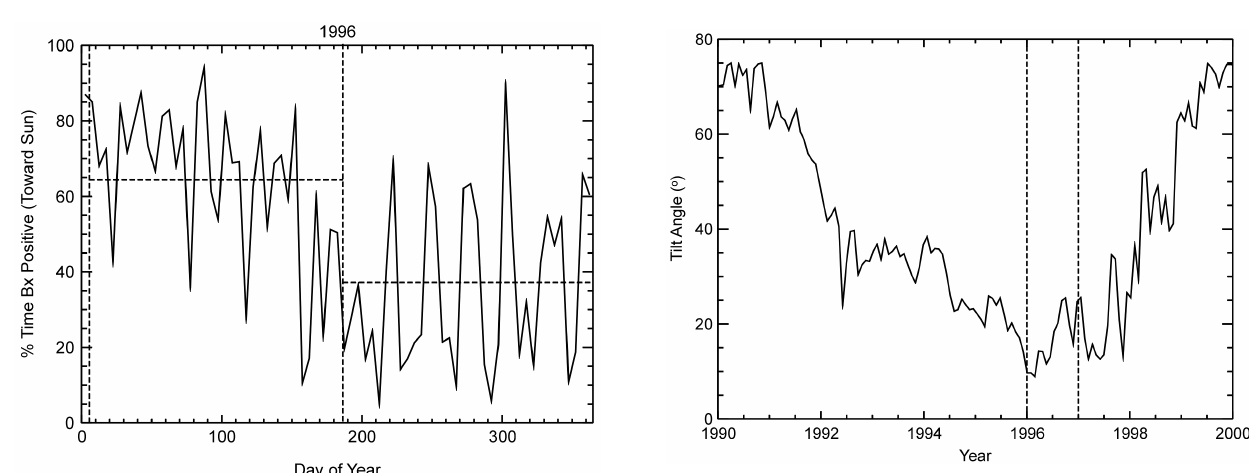
Fig. 4. Solar wind magnetic polarity distribution (5-day averages) at the Earth during 1996. Fields with positive (negative) B x are di- rected toward (away from) the Sun. The dashed vertical lines indi- cate mimima (favourable polarity cross-over times) for the Russell- McPherron effect. The dashed horizontal lines give average per- centages of the time B x is positive for intervals bounded by these crossings (the second interval is truncated on 31 December). Note that B x has the opposite sign of the solar/solar wind magnetic po- larity.